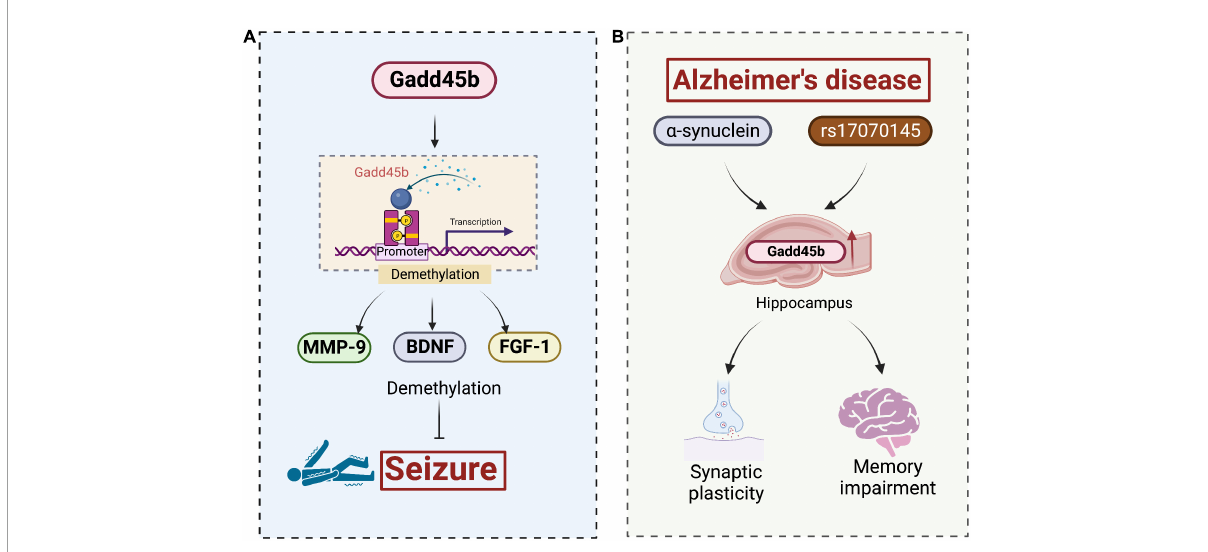
FIGURE6 Roles of growth arrest and DNA damage-inducible beta (Gadd45b) in the seizures and Alzheimer’s disease. (A) Gadd45b suppresses seizures by altering the demethylation of MMP-9, BDNF, and FGF-1. (B) α -synuclein and rs17070145, recognized pathological features in AD, promote Gadd45b expression in hippocampal, facilitating synaptic remodeling and memory repairment (Figure was created with